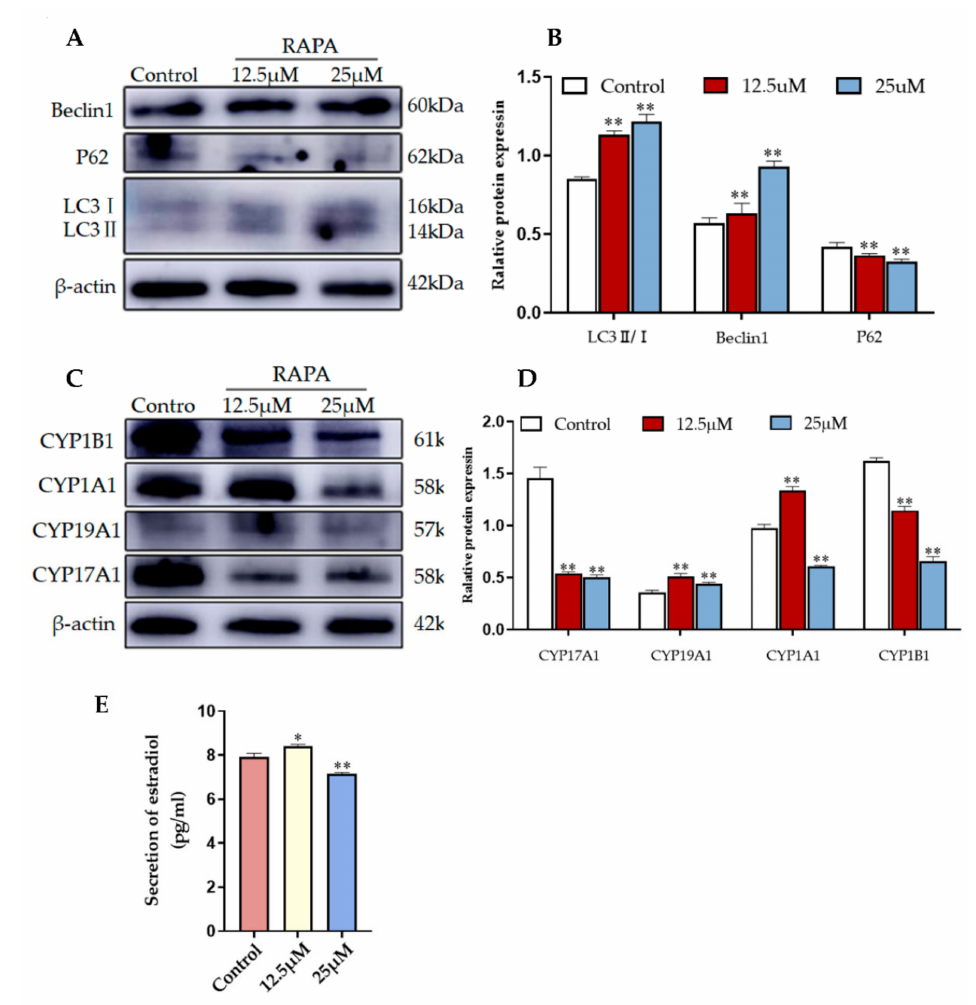
Figure 7. RAPA increases 2-OHE 2 secretion by upregulating autophagy in YCCs. ( A , B ) Western blot analysis of the protein expression in YCCs. ( C , D ) Quantitative results of the Western blot (See Figure S4). ( E ) ELISA kit analysis of the concentrations of estradiol (pg/mL) in the cell supernatant. Data are expressed as the mean ± SD. n = 3. * p < 0.05 and ** p < 0.01 indicate significant differences between the yak follicular fluid exosome treatments and the